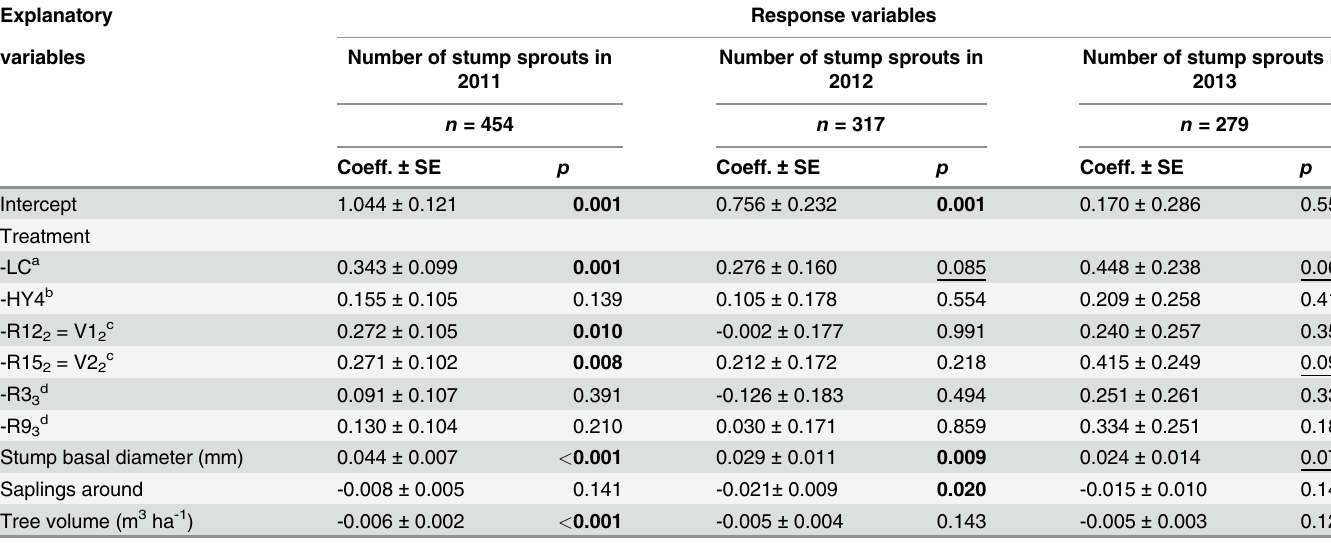
Table 5. Differences in the Number of Stump Sprouts of Living Birches between the C . purpureum Strain R5 3 and Other